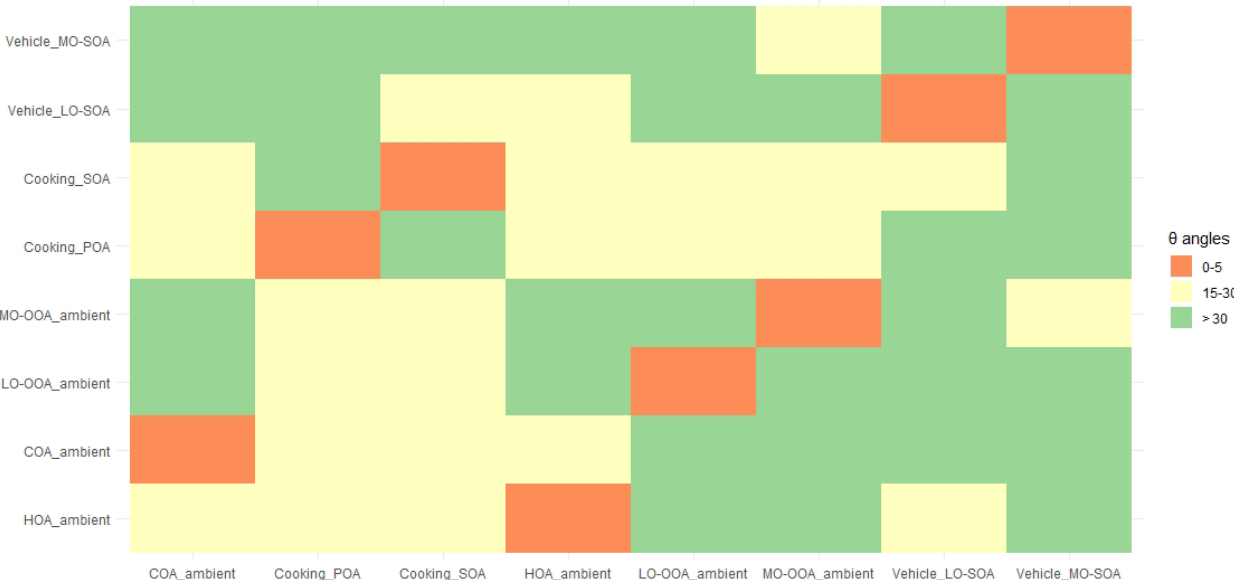
Figure 4. The θ angles between ambient COA, HOA, LO-OOA, and MO-OOA factors, the cooking PMF, POA, and SOA, and the vehicle LO-SOA and MO-SOA. The θ angle between two mass spectra is 0–5, 5–10, 10–15, and 15–30, and > 30 indicates excellent consistency, good consistency, many similarities, limited similarities, and poor consistency, respectively. The ambient COA, HOA, LO-OOA, and MO- OOA factors were averages of the resolved factors which were found in Shanghai, Dezhou, Beijing, and Shenzhen data sets (Hu et al., 2017; Zhu et al.,